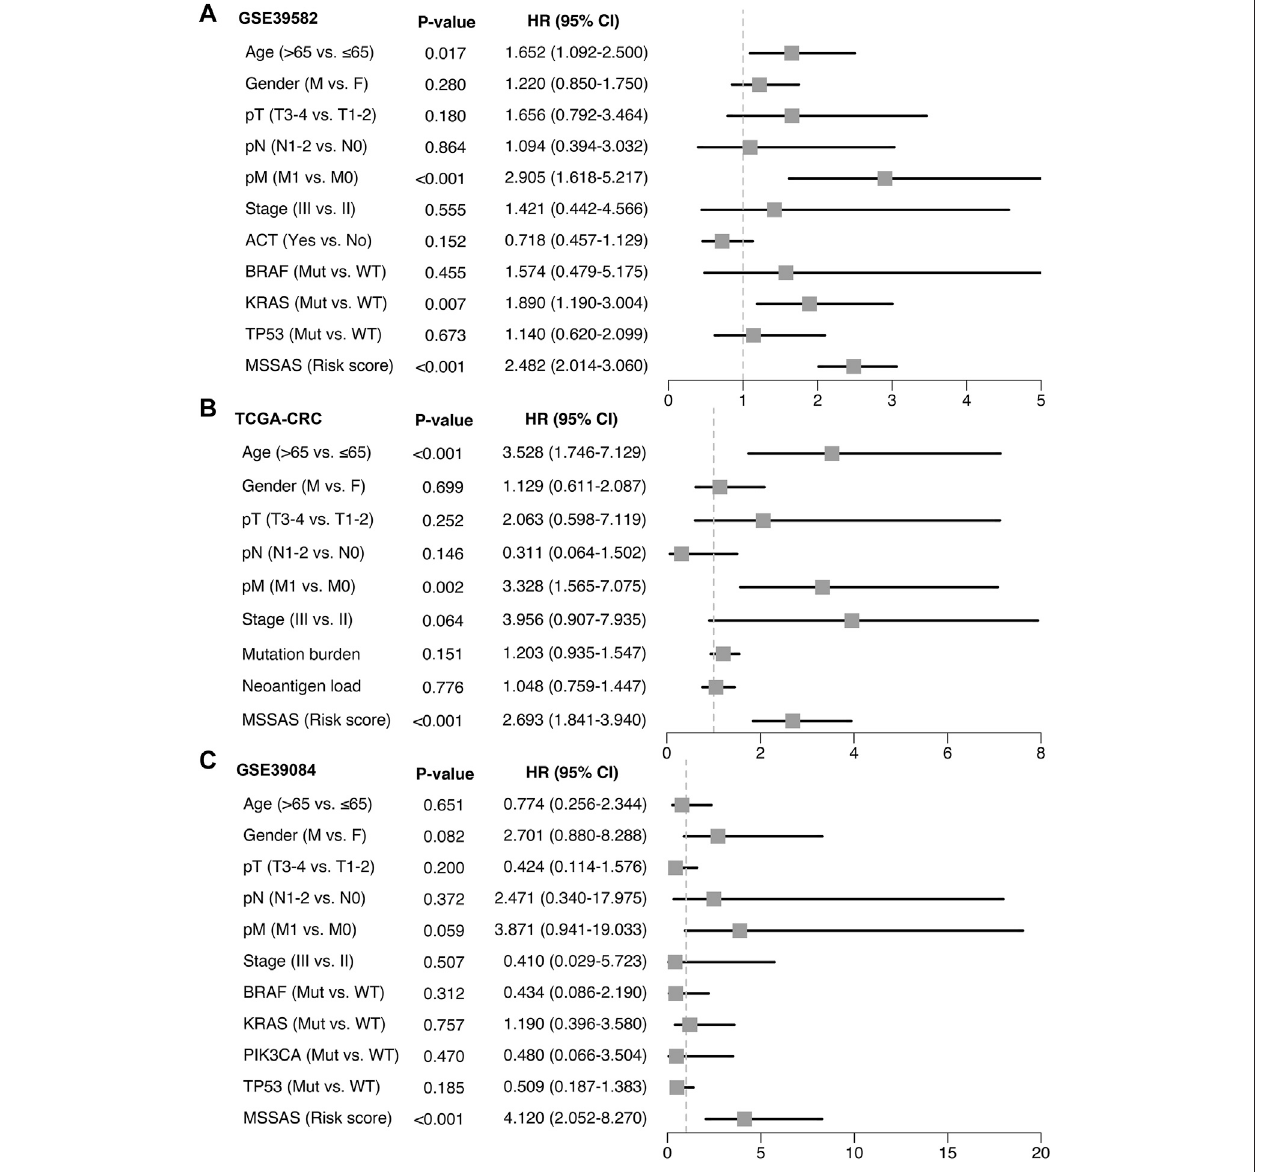
Frontiers in Cell and Developmental Biology |